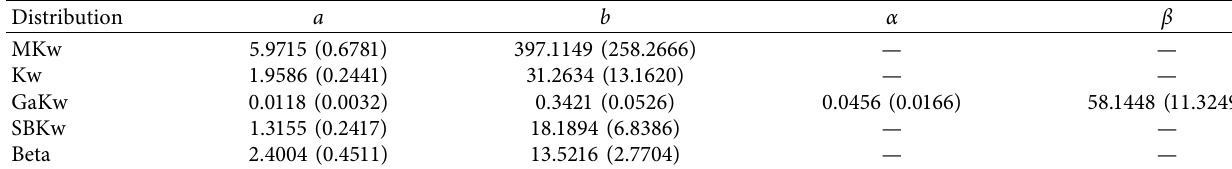
Table 8: MLEs and their standard errors (in parentheses) for data set 2.